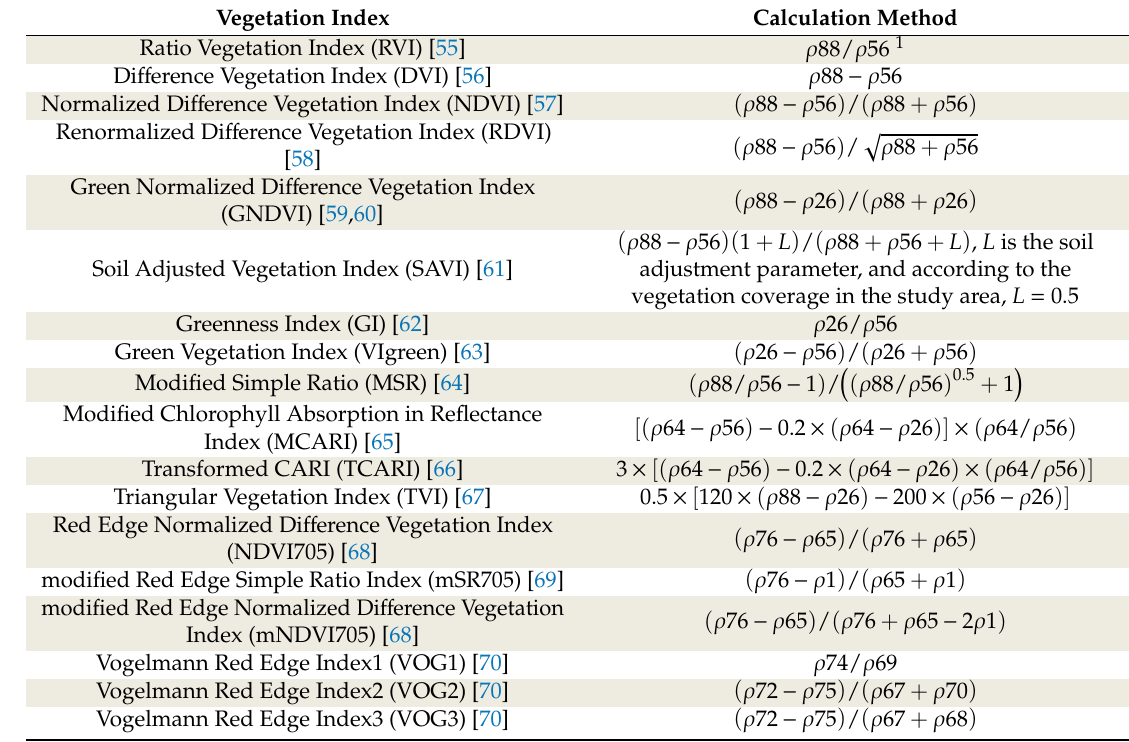
Table 3. Vegetation index and calculation